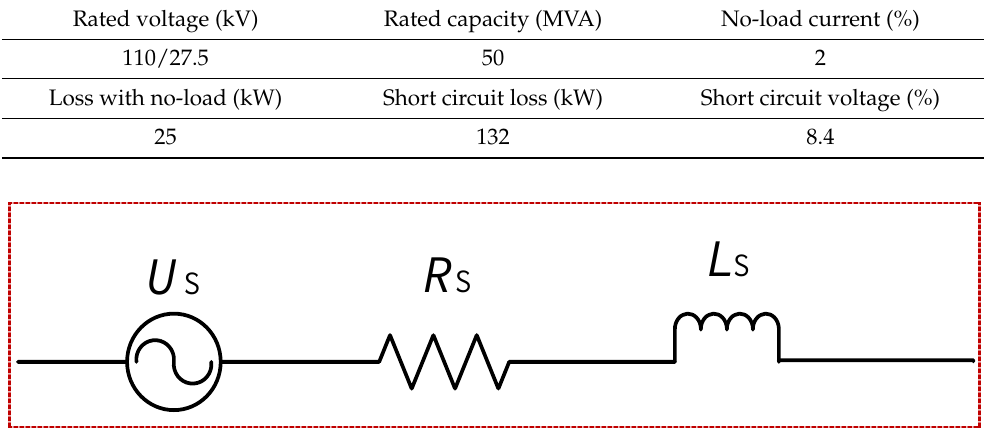
Table 1. Main technical parameters of the traction transformer.